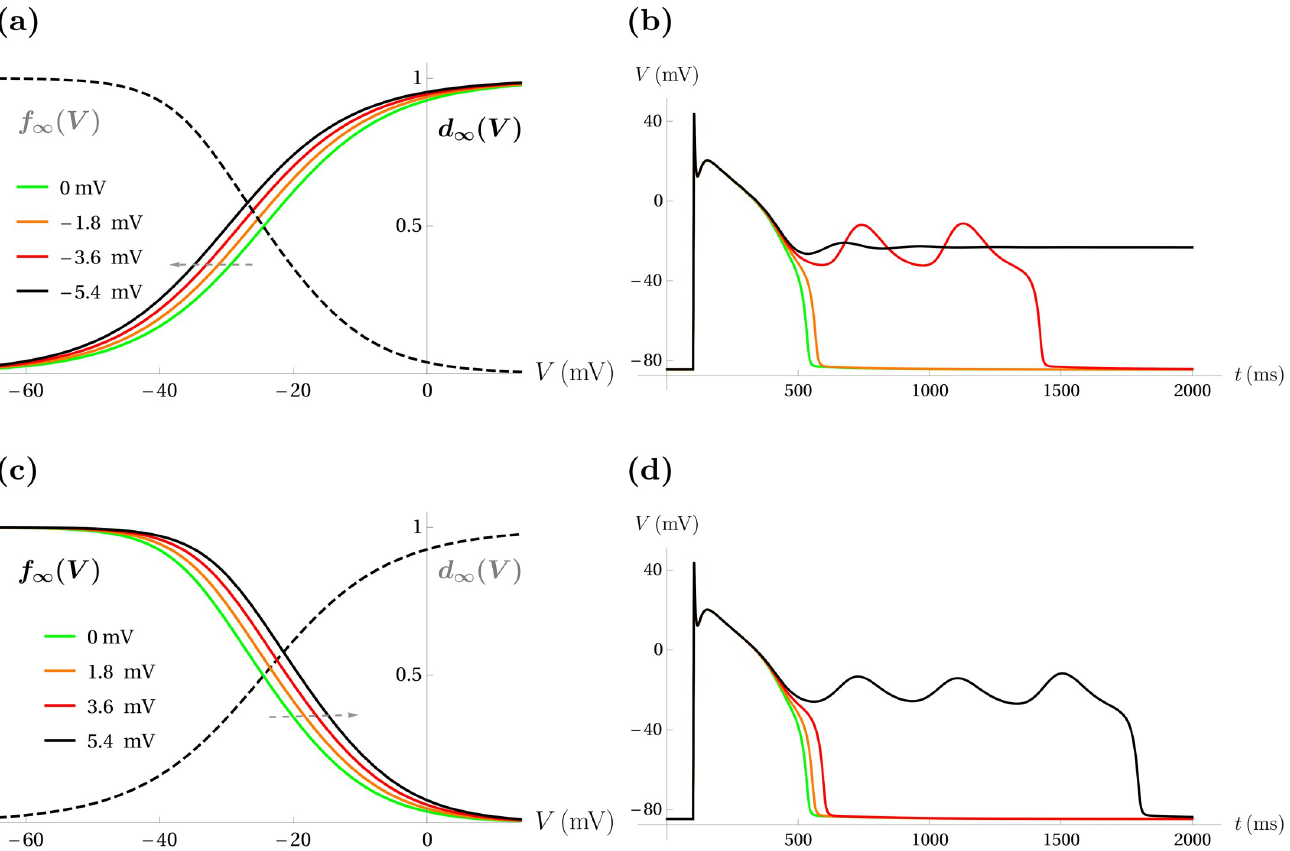
Fig 4. Left shifts in the Ca 2+ current activation curve are more effective at inducing EADs and repolarization block than right shifts in the inactivation curve. ( a ) Three equally-spaced left shifts in d 1 ( V ) (ordered orange, red, then black) are shown, while leaving f 1 ( V ) (dashed, black) unchanged. As in Fig 3, green denotes the default. The shifts are given in the legend. ( b ) The model responses to the left-translations shown in (a) mirror those of Fig 3b: sufficiently large translation induces two EADs (red trace) and the largest translations lead to repolarization failure (black trace). ( c ) Right shifts in f 1 ( V ) of equal size to those of (a). ( d ) The model responses to increasing Δ V 1/2 ( f 1 ) are less severe than those of equally-sized changes in Δ V 1/2 ( d 1 ): the largest change in Δ V 1/2 ( f 1 ) produces EADs (black trace) instead of repolarization